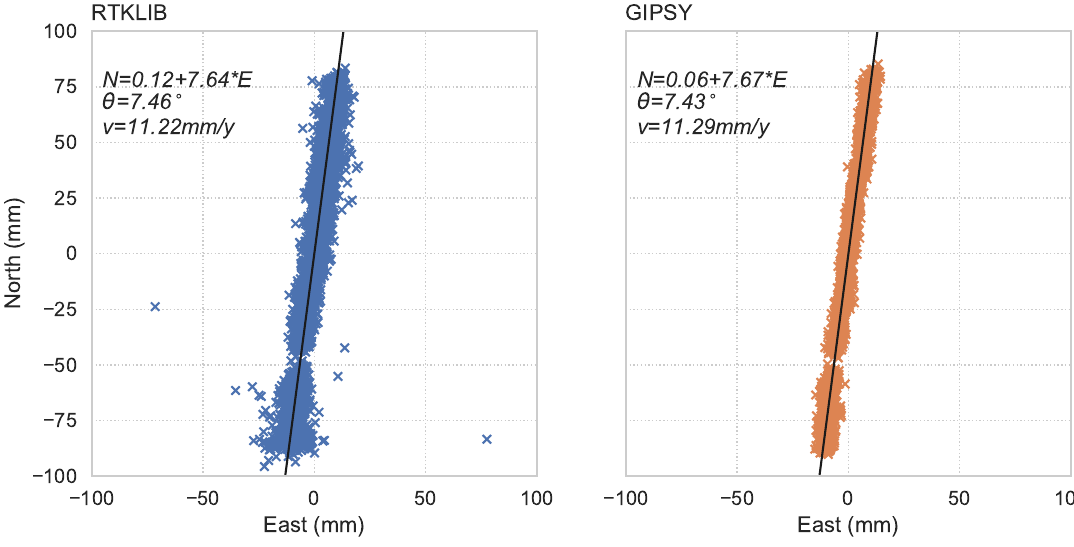
Figure 13. Scatter plot and direction of the horizontal vector at Aboa between 1 February 2003 (2003–032) and 8 December 2017